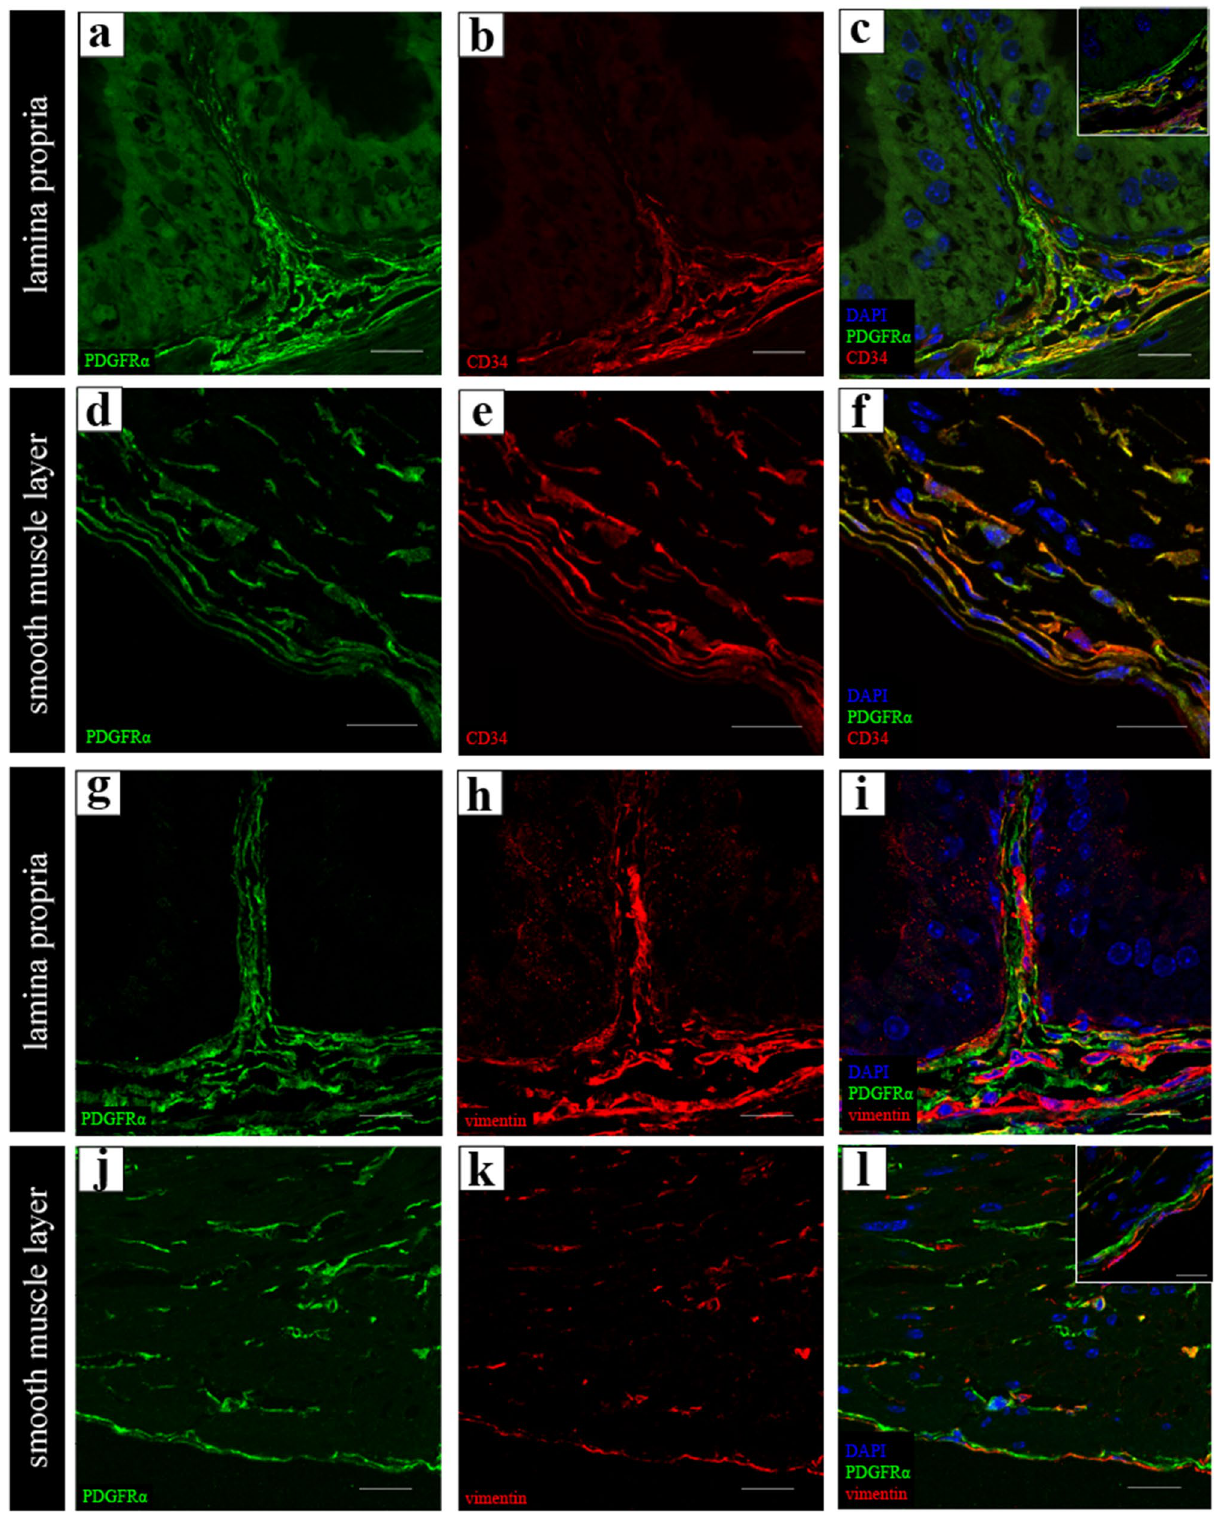
Figure 3. ( a–f ) Representative images of the double immunolabeling for PDGFRα (green) and CD34 (red) in the lamina propria ( a – c ) and in the smooth muscle layer ( d – f ). High magnification in the area beneath the epithelium (inset at the upper right corner of ( c )). PDGFRα- immunoreactivity (IR) observed beneath the epithelium was not co-labeled with CD34-IR ( c ). PDGFRα-IR observed within the deeper portions of the lamina propria, in the smooth muscle and serosal layers were co-labeled with CD34 ( c , f ). ( g – l ) Representative images of the double immunolabeling for PDGFRα (green) and vimentin (red) in the lamina propria ( g – i ), in the smooth muscle layer and serosal layer ( j – l ). PDGFRα-IR was partially co-labeled with vimentin-IR in all layers ( c , f ). High magnification in the serosal layer (inset at the upper right corner of ( l )). Vimentin-single IR cells were observed in the outermost of serosal layer ( f ). Nuclei were counterstained in blue with 4 ′ ,6-diamidino-2-phenylindole ( c , f , i , l ). Scale bars: 20 µm ( a – l ), 5 µm (inset at the upper right corner of ( c , l